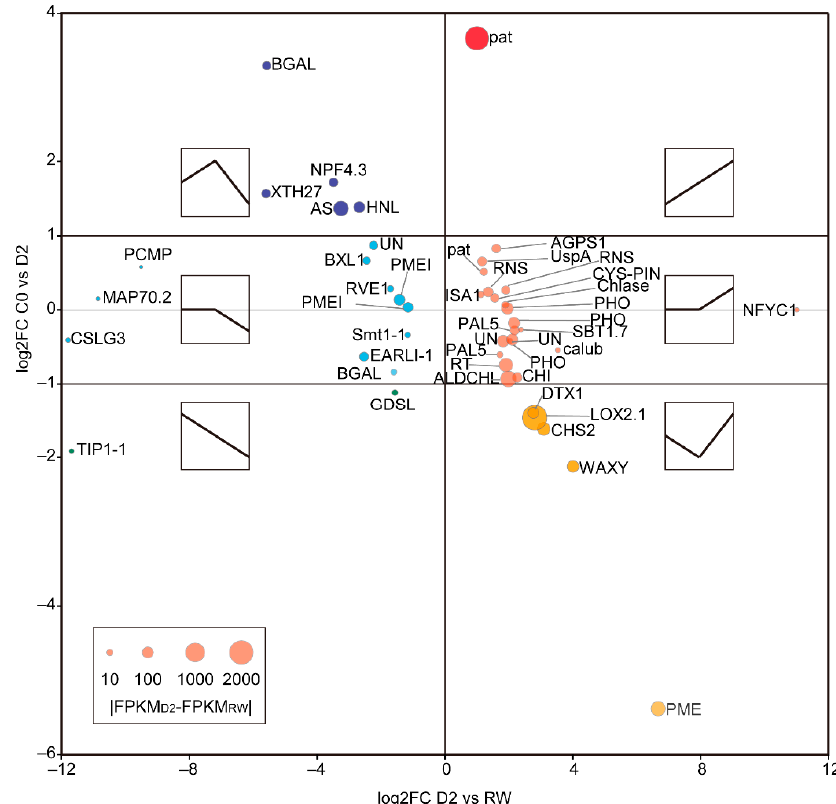
Figure 5. DEGs after rehydration compared with C0 and D2. The red and orange bubbles indicate upregulated genes with C0 and D2, while the blue and green indicate downregulated genes. The area of the circle indicates the di ff erence of expression between D2 and RW. The line charts in the small square frame are expression trends of genes in the coordinate